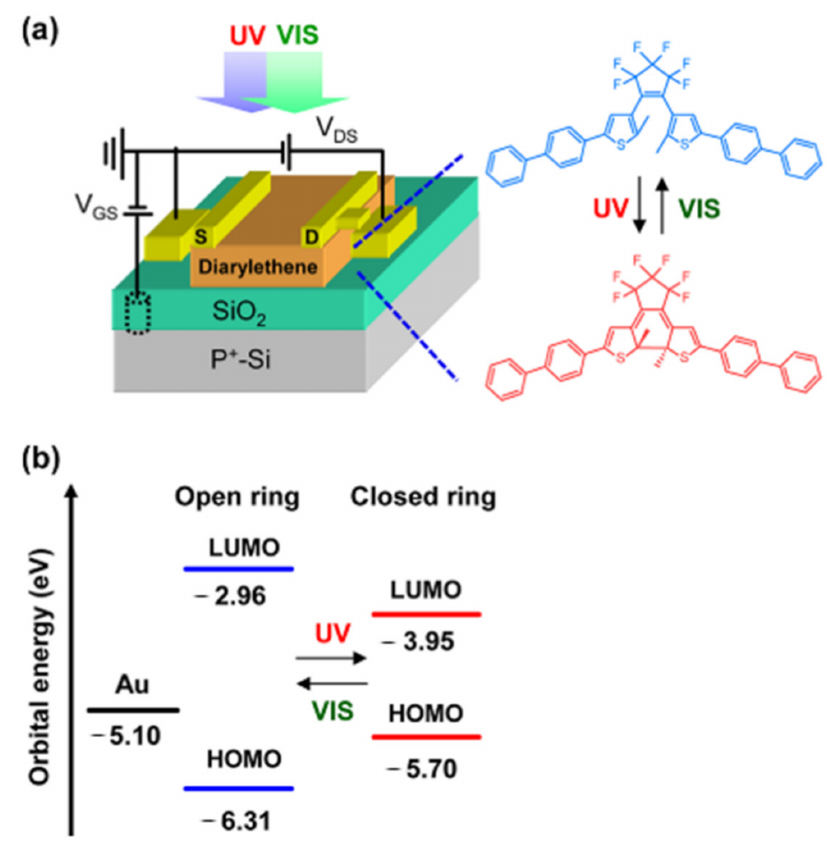
Figure 12. ( a ) Schematic of device structure and isomerisation process, ( b ) the corresponding energy levels. Reprinted with permission from ref. [113]. Copyright 2013 American Chemical Society.